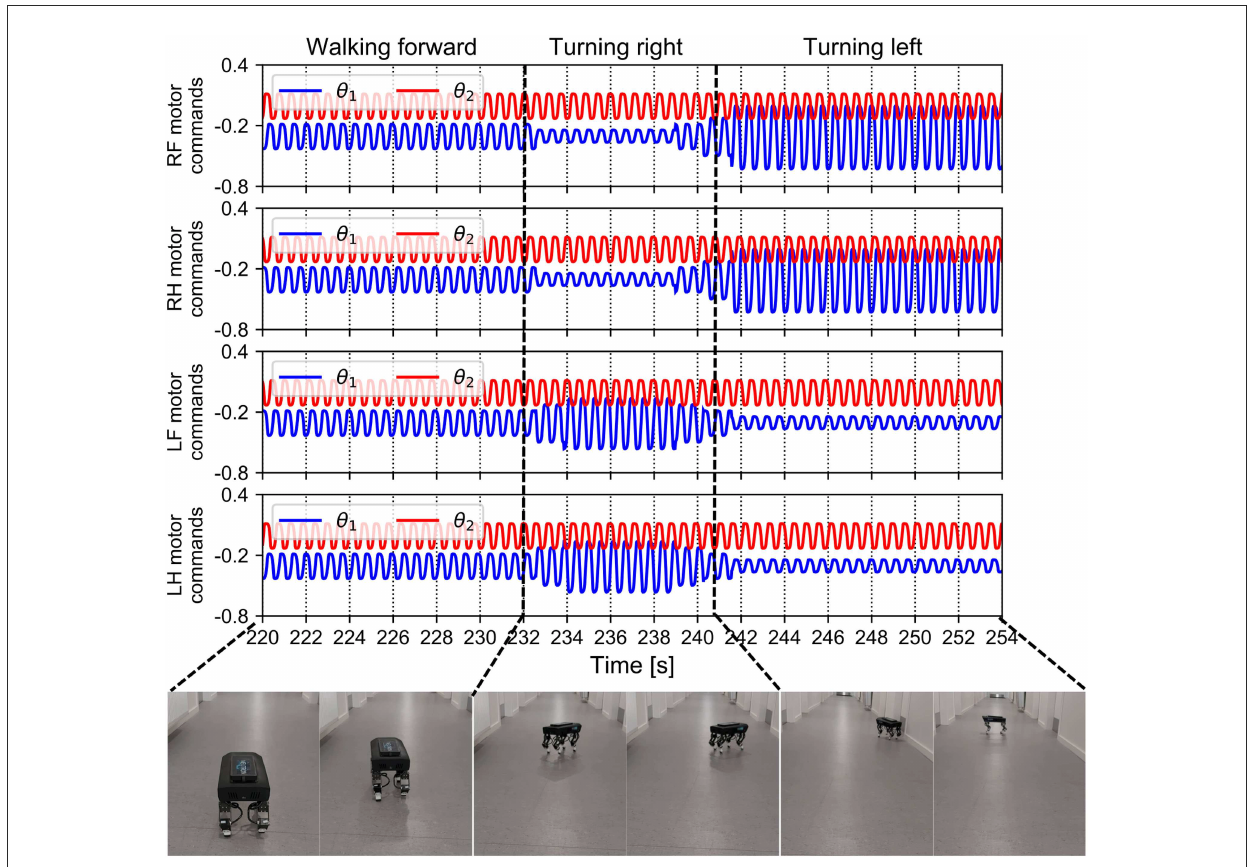
FIGURE14 Motor commands fed to Lilibot and its walking direction under these commands. The four legs received periodic commands with the same amplitudes after the control converged and the robot walked forward. After approximately 232 s, the robot was made to turn right by setting the amplitudes of the left leg motor commands to be larger than normal and those of the right side became lower than normal. After 241 s, the setting of the amplitudes was reversed and the robot turned left.